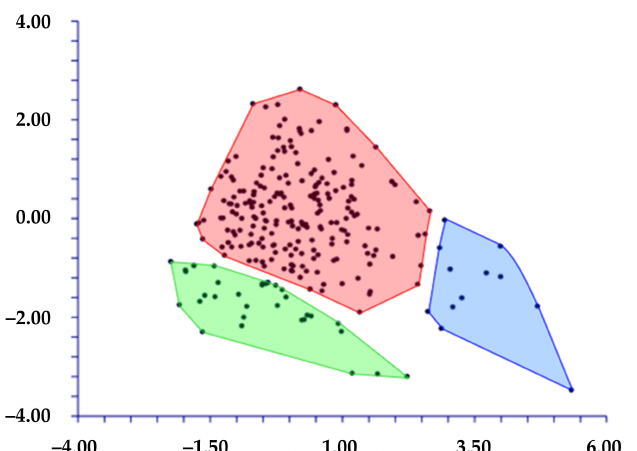
Figure 5. PCA (first ( x axis) vs. second ( y axis) components) based on the 22 quantitative morpho- logical characters. Blue polygon: Ventotene population; green polygon: Terracina population; red polygon: other